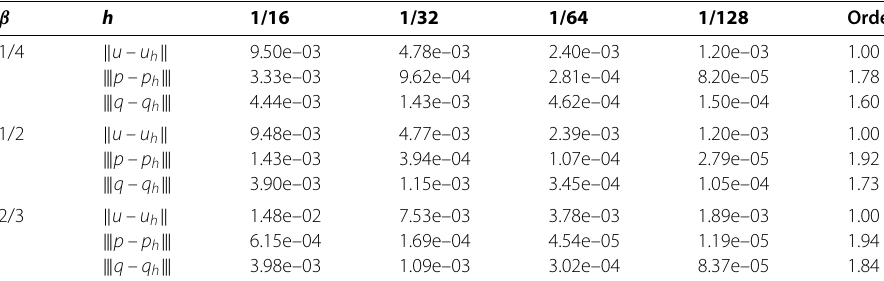
Table 2 Numerical results for Example 1 with h = 2 –8 and β = 2